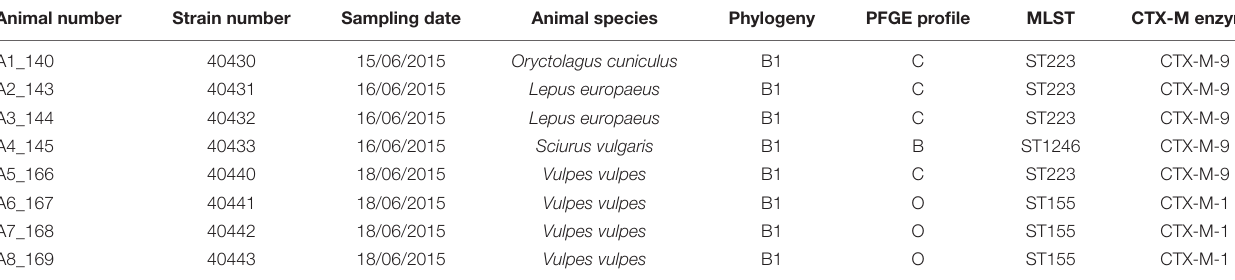
TABLE 3 | Characteristics of the eight E. coli isolates collected from mammals in the rescue center.